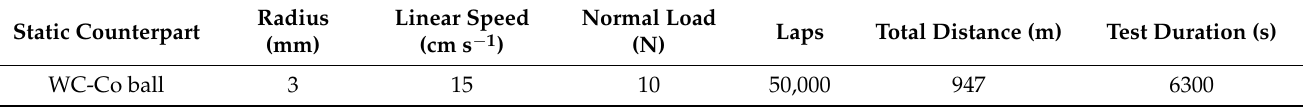
Table 3. Pin-on-disk test parameters.